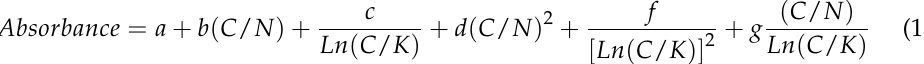
Figure 4. Pearson Product–Moment Correlations. Independent variables: C/N ratio, C/K ratio; dependent variable: absorbance at 1060 cm − 1 .